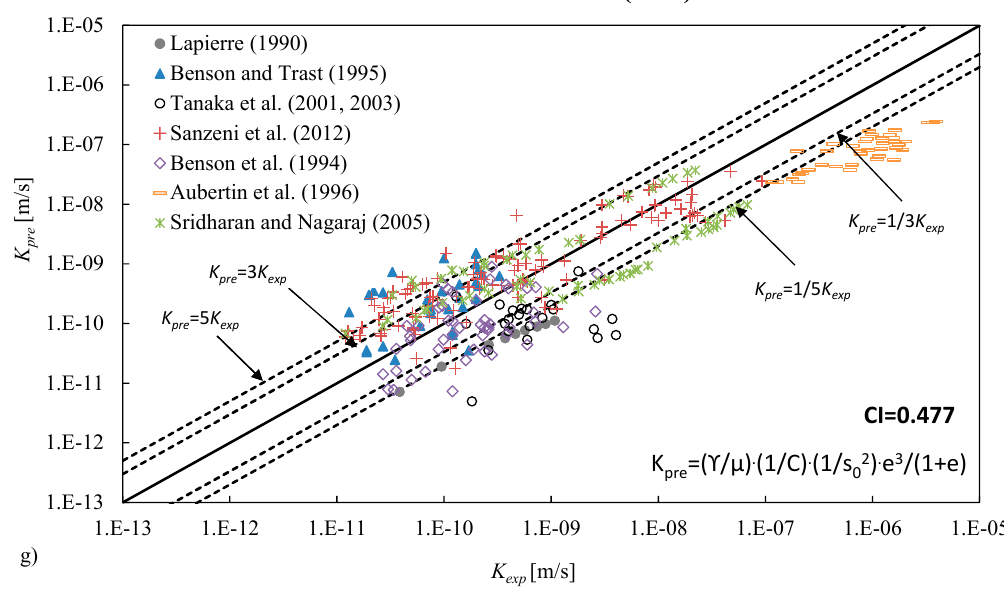
Figure 7. Experimental ( K exp ) and predicted value ( K pre ) of the saturated hydraulic conductivity as determined by ( a ) Equation (2), ( b ) Equation (3), ( c ) Equation (6), ( d ) Equation (7), ( e ) Equation (9), ( f ) Equation (11), and ( g ) Equations (1) and (13).